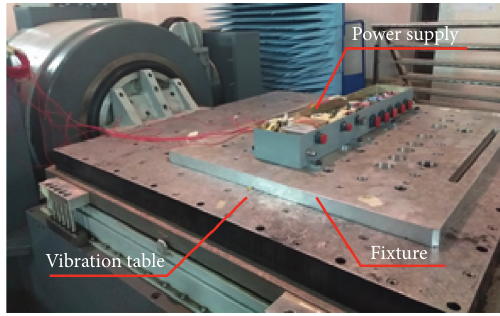
Figure 2: The vibration test site.